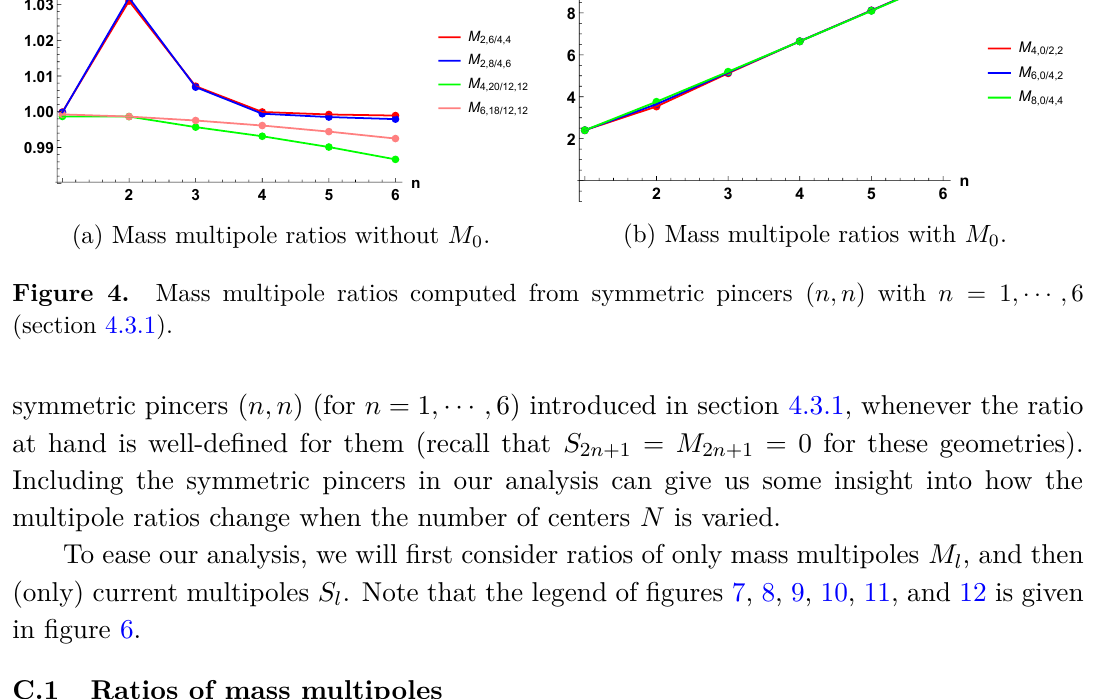
(b) Mass multipole ratios with M 0 .